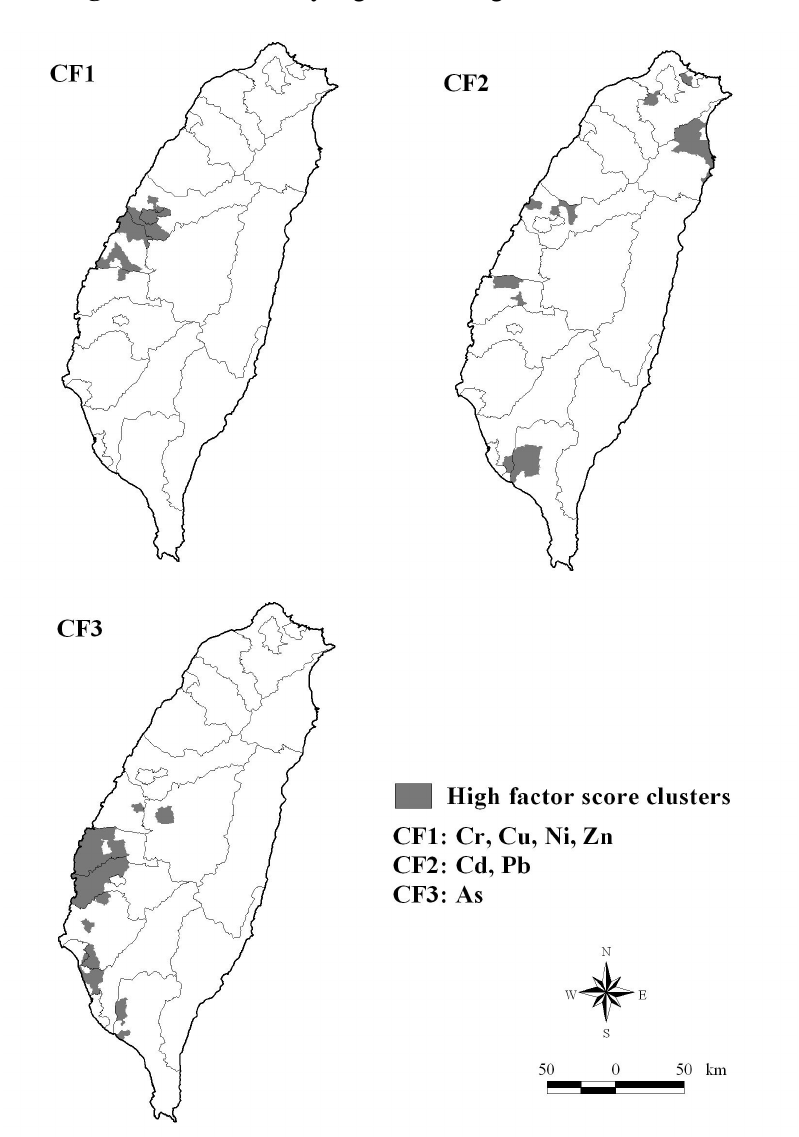
Figure 2. Statistically significant high factor score